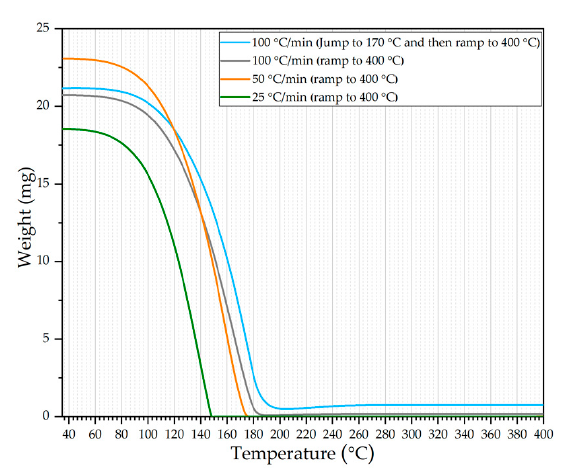
Figure 2. TGA curves of tungsten hexacarbonyl at different heating rates in nitrogen.